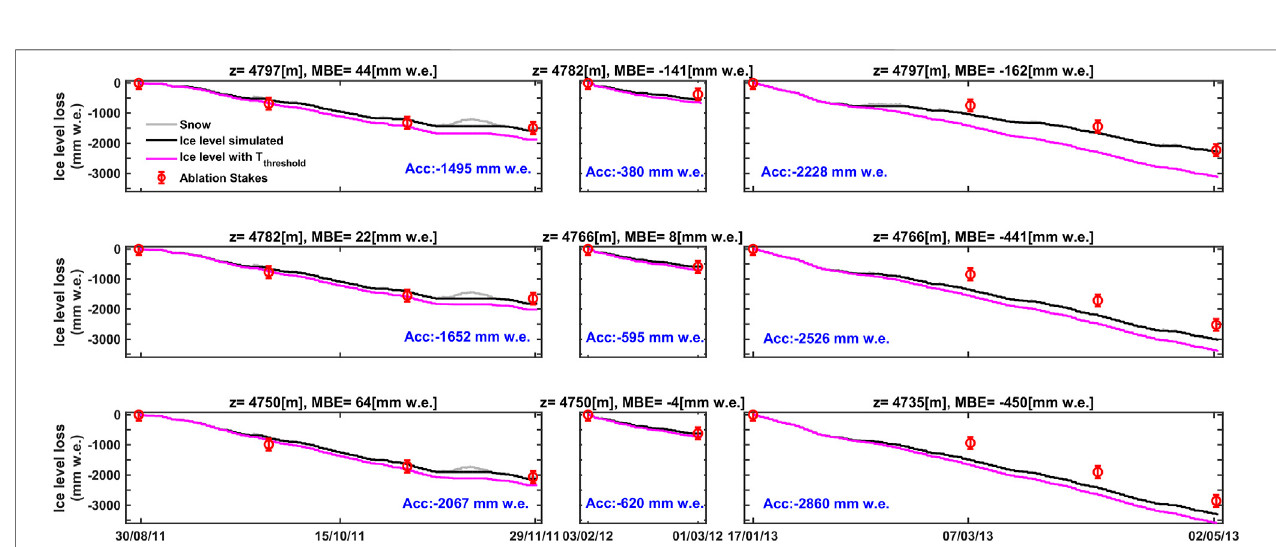
FIGURE 6 | Computed and measured surface height changes for different sites (rows) during MP1, MP2, and MP3 (columns). Ice (black line) and snow (gray line) surfaceheightwerecomputedfollowingthePSOscheme.Surfaceheightmeasured(redcircles)includes150 mmerrorbarsrelatedtothemeasurementmethod. Mean bias error (MBE) between simulated and measured surface height, and cumulated height measured (text in blue) were included for each site. For comparison purposes, surface height computed with a 1 ° C threshold temperature (pink line) is also shown.